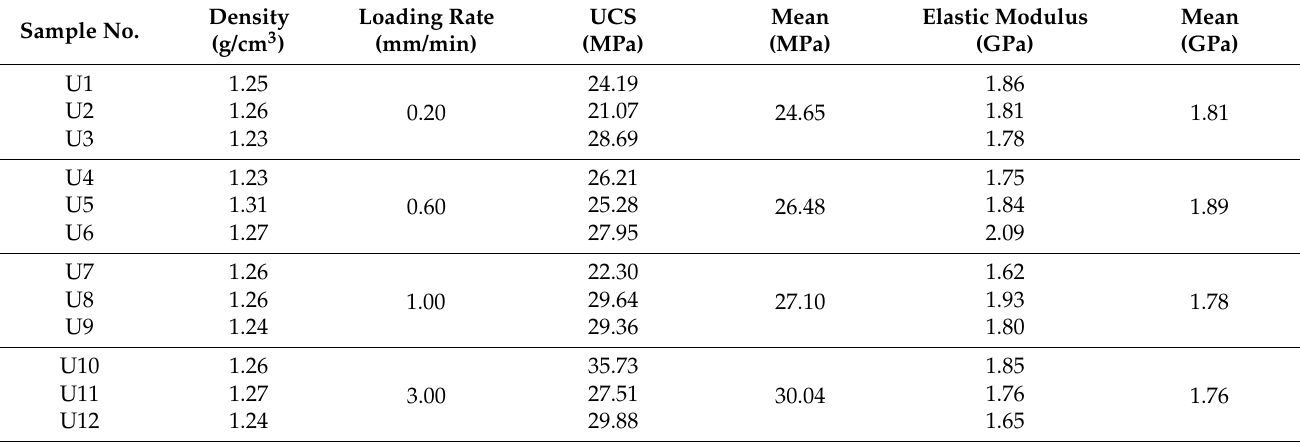
Table 2. Mechanical properties of coal